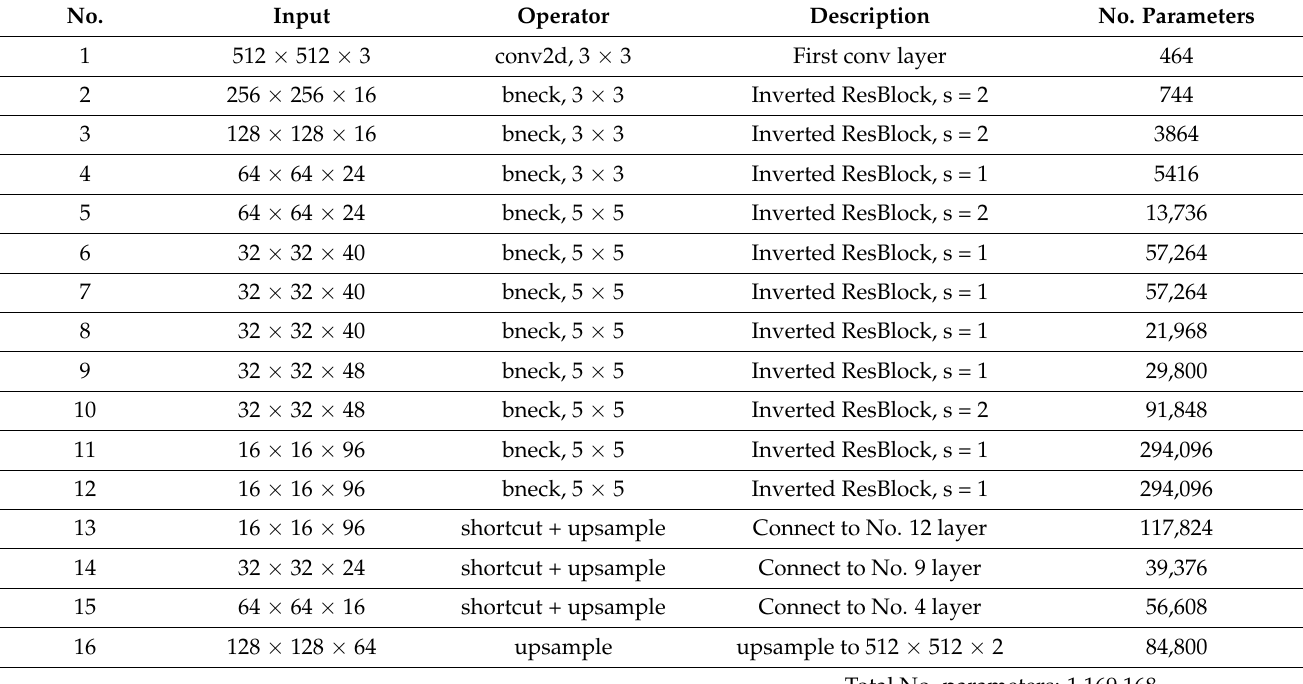
Table 1. The architecture of the lightweight Mobile-UNet